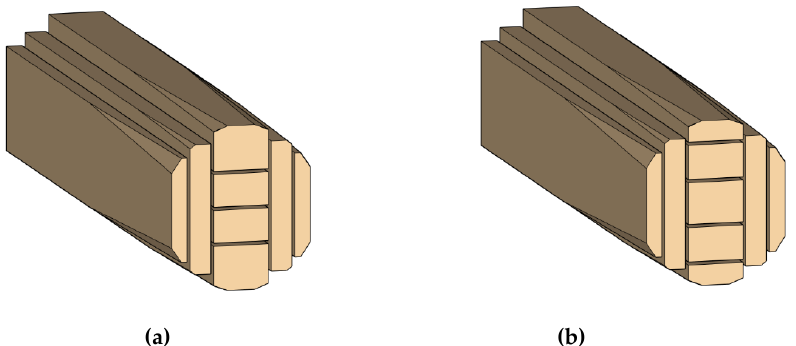
Figure 7. Layout of the cutting pattern in relation to the center of the log with the compound cutting pattern. ( a ) The cutting plane passes through the center of the log, ( b ) the center of the log is a part of the central